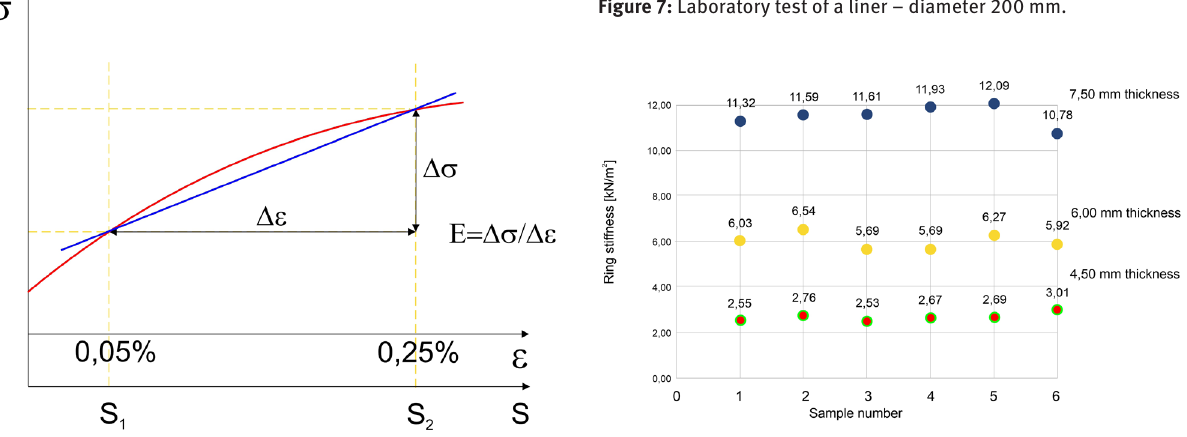
Figure 7: Laboratory test of a liner – diameter 200 mm.